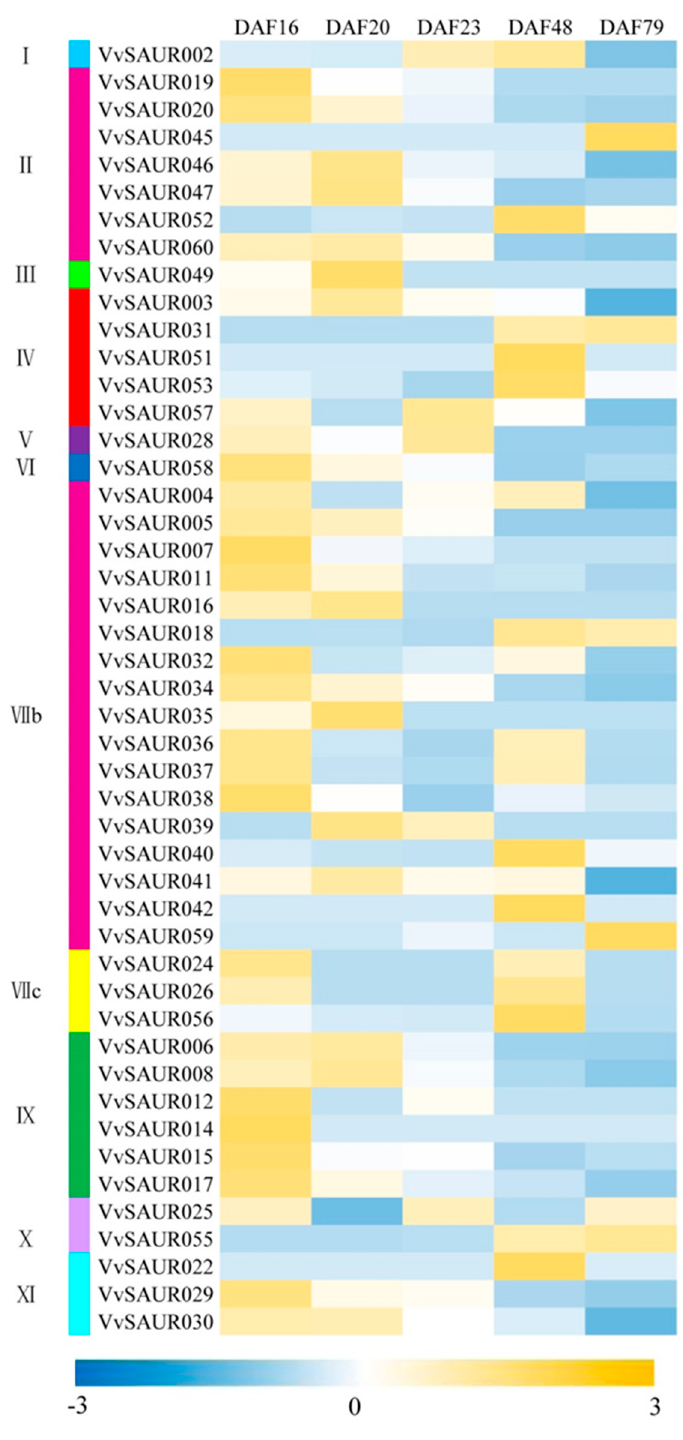
Figure 5. VvSAUR family heatmap of ‘Hong yan Seedless’ berry for five critical development